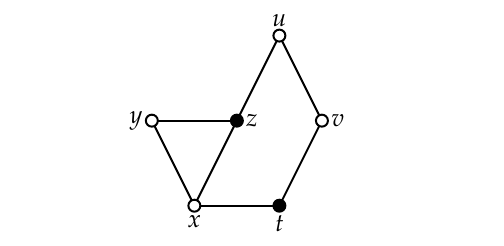
Figure 1. Black vertices form a maximal shortest paths